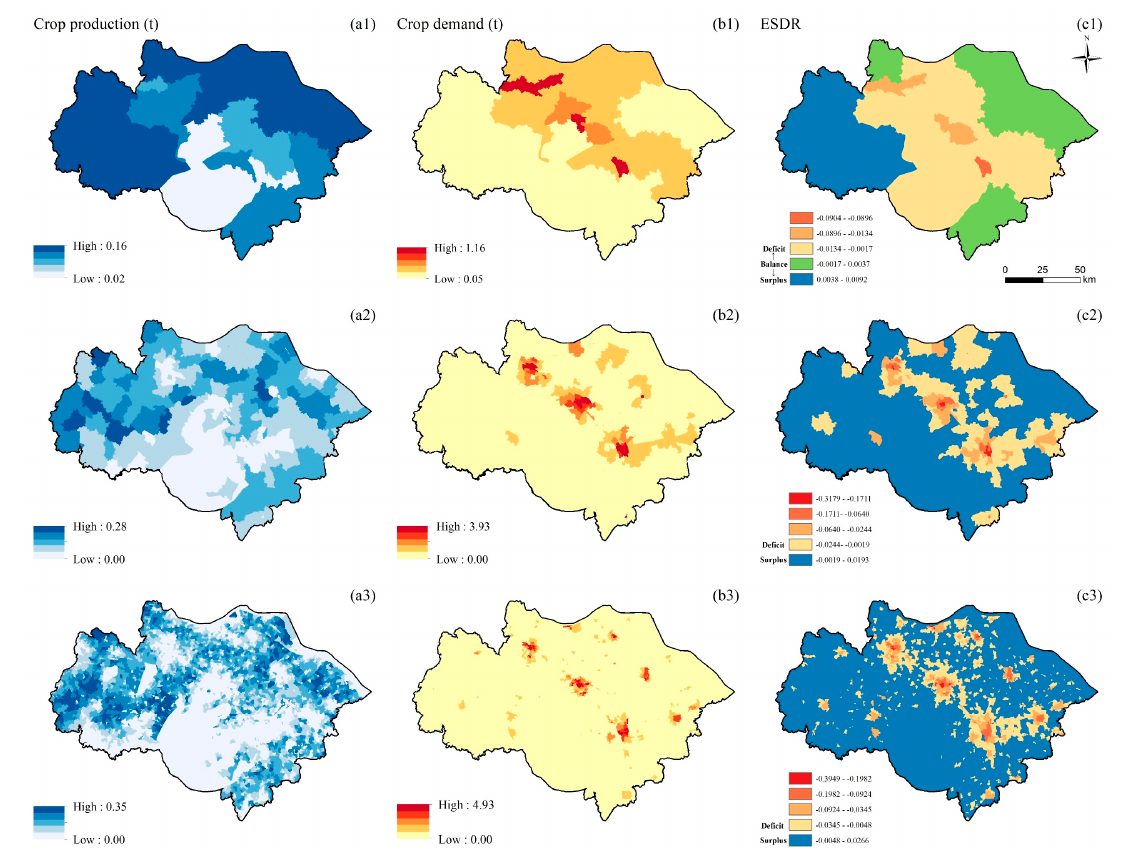
Figure 2. Spatial distribution of CP (unit: t/900 m 2 ) at the county ( a1 , b1 , c1 ), township ( a2 , b2 , c2 ), and village ( a3 , b3 , c3 ) scales; supply of CP ( a1 – a3 ); demand for CP ( b1 – b3 ); ESDR ( c1 – c3 ).